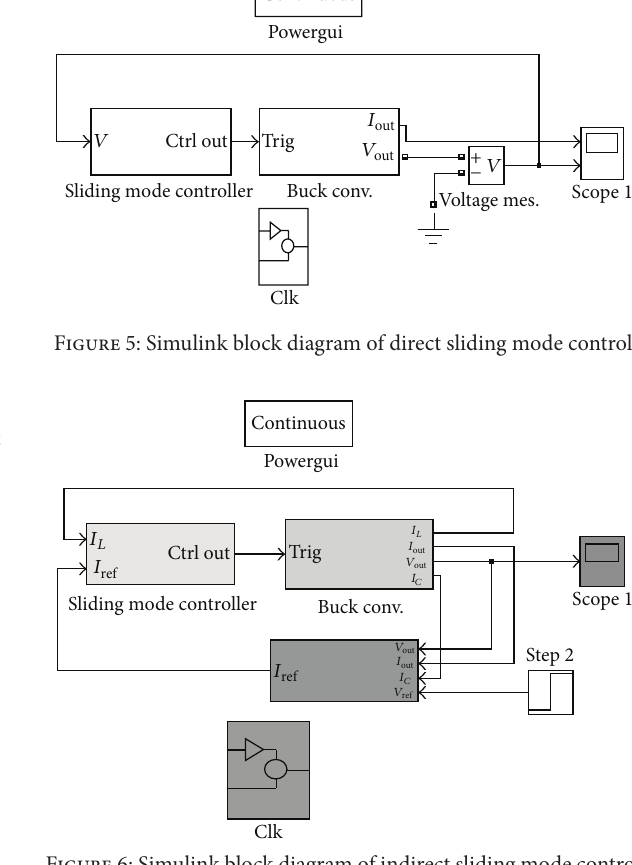
Figure 6: Simulink block diagram of indirect sliding mode